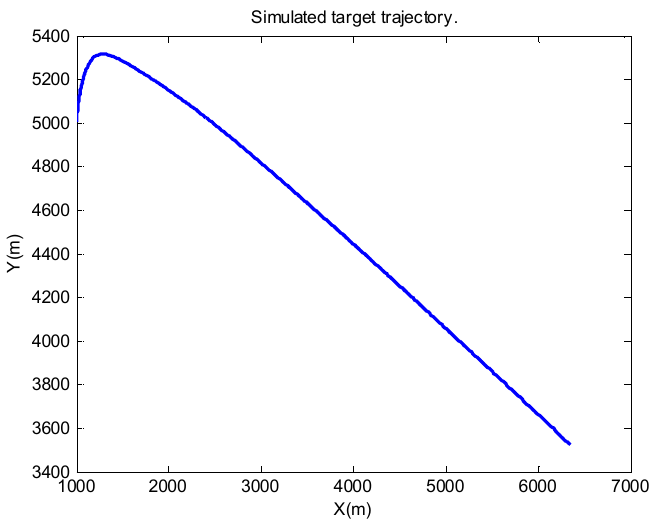
Figure 2. Flight trajectory of the target.